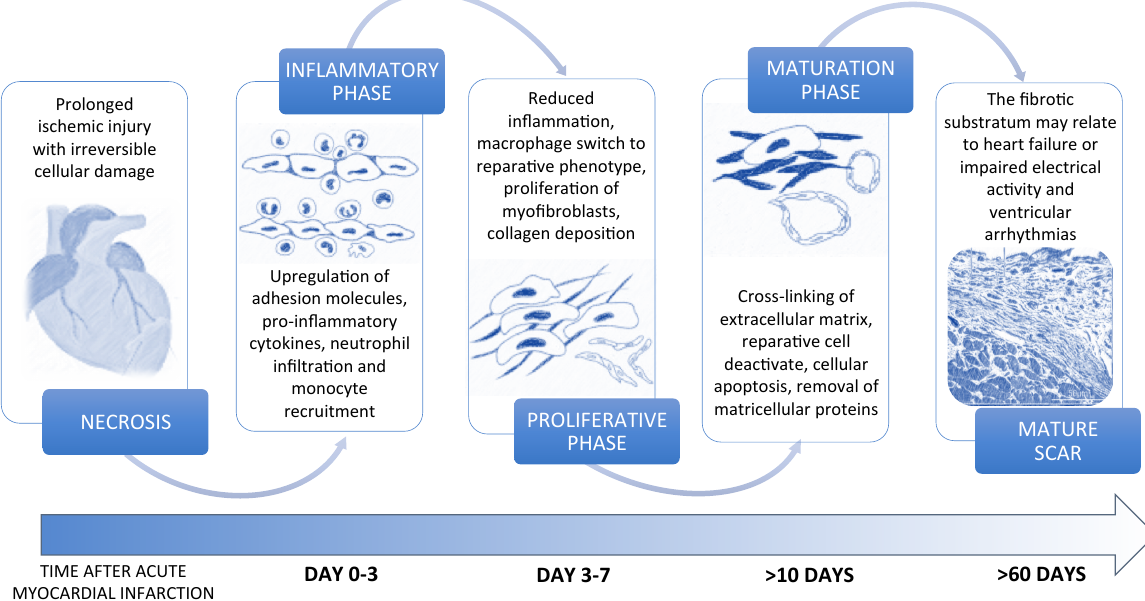
Figure 1. Different phases of the healing process after myocardial